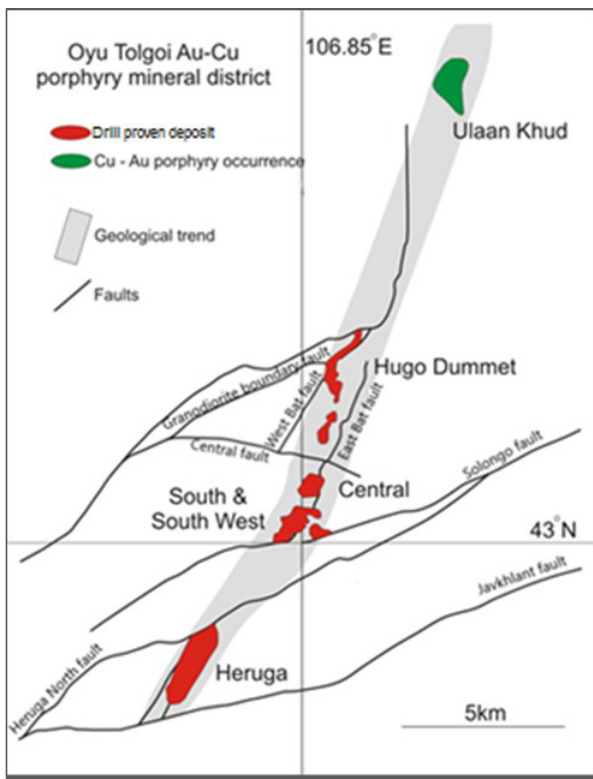
Fig. 2. The Oyu Tolgoi group deposits and main